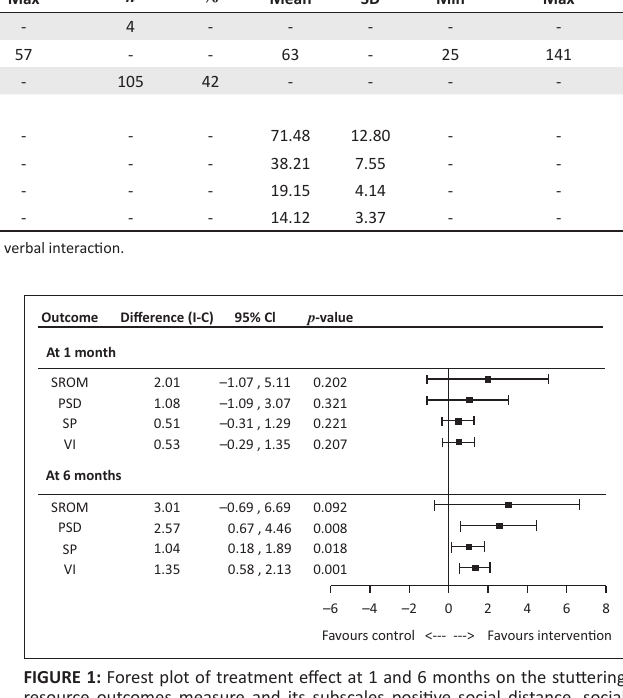
TABLE 2: Baseline characteristics of study participants by study group. Variable